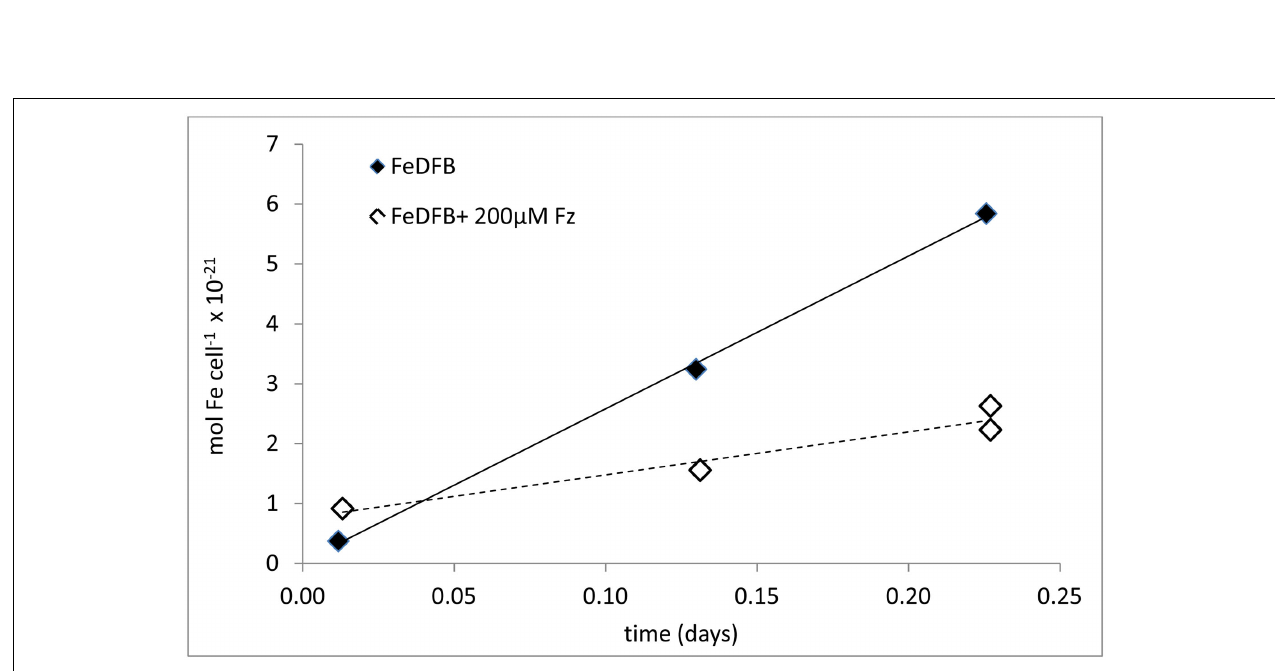
on the right top and bottom respectively. Fe(II)Fz 3 and Fe(II)BPDS 3 are detected spectrophotometrically at 562 and 533nm, respectively. Additionally Fe(II)Fz 3 and inhibition of Fe uptake by Fz/BPDS can be detected in radioactive experiments. Figure based on Lis and Shaked (2009).